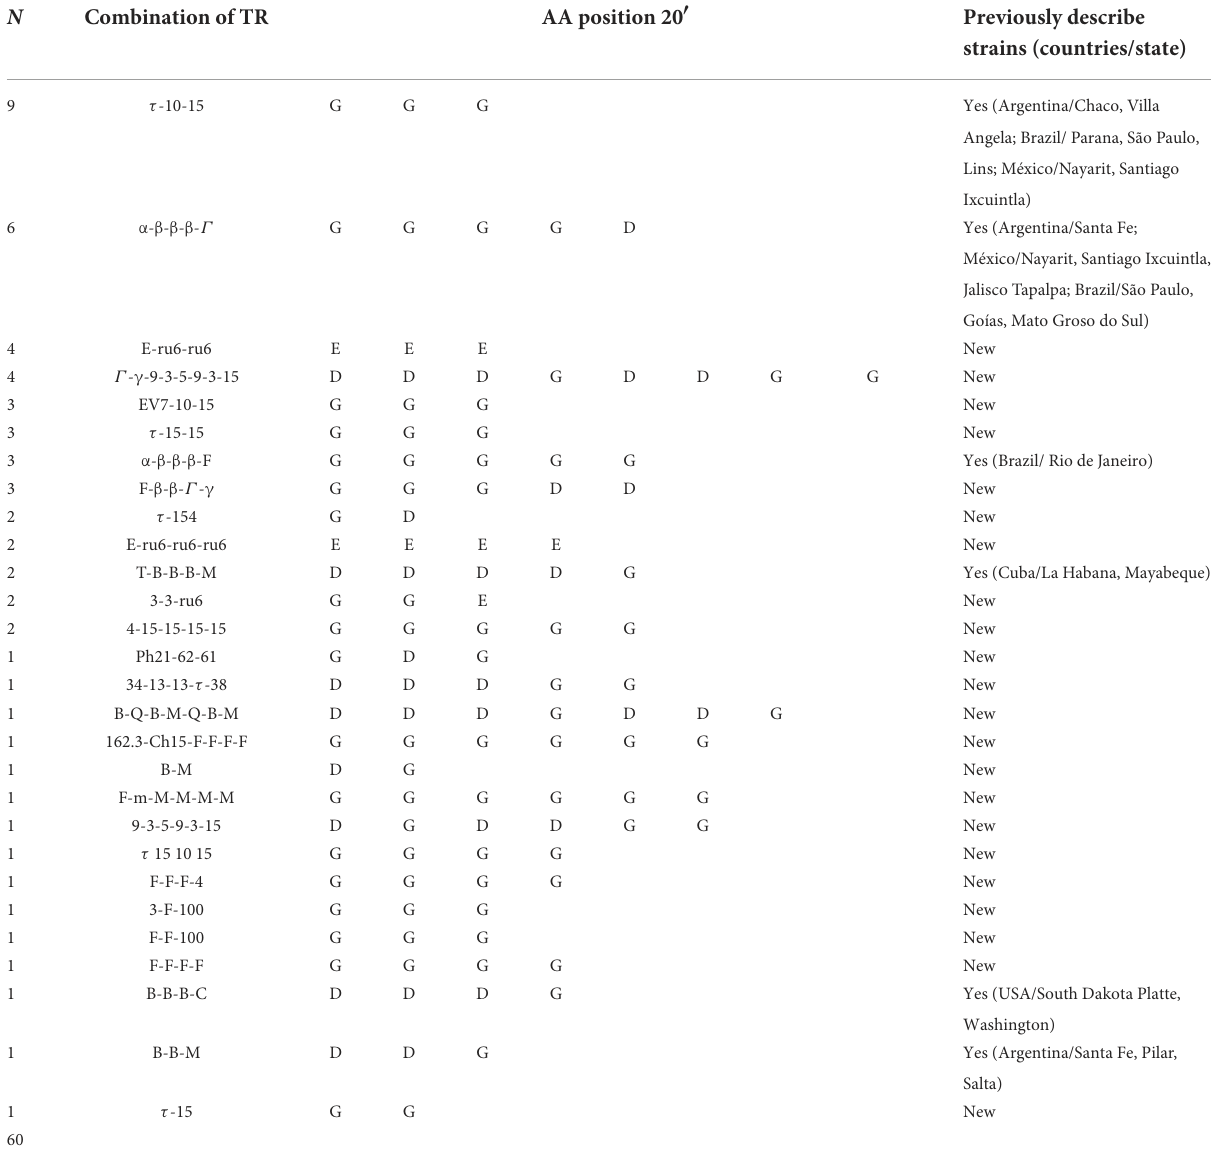
TABLE 2 Characterization of Anaplasma marginale strains according to the combination of tandem repeat. N Combination of TR AA position 20 ′ Previously describe